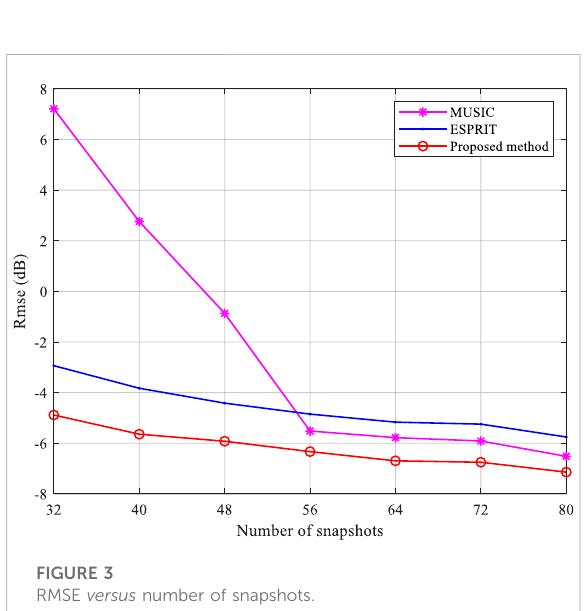
FIGURE 3 RMSE versus number of